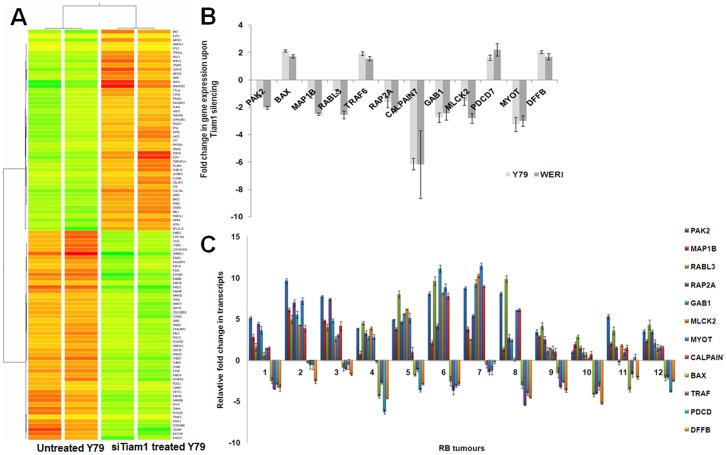
cDNA microarray in Tiam1 silenced Y79 and validation of de-regulated genes in RB cell lines & tumors.
A. Whole genome microarray of Tiam1 silenced Y79 cells was performed using Human-Ht12 beadChip ver. 3 platform. Hierarchical Cluster represents the expression profile of de-regulated genes upon Tiam1 silencing in Y79 cells, compared to untransfected cells. B. Real-time PCR results showing the mRNA expression of selected genes from microarray analysis in Tiam1 silenced Y79 and Weri-Rb1 cells C. Relative fold change in the mRNA expression of selected panel of genes verified in primary retinoblastoma showing the negative correlation to that of Tiam1 silenced Y79 and Weri-Rb1 retinoblastoma cells. Error bar represents the standard deviation of triplicates value.